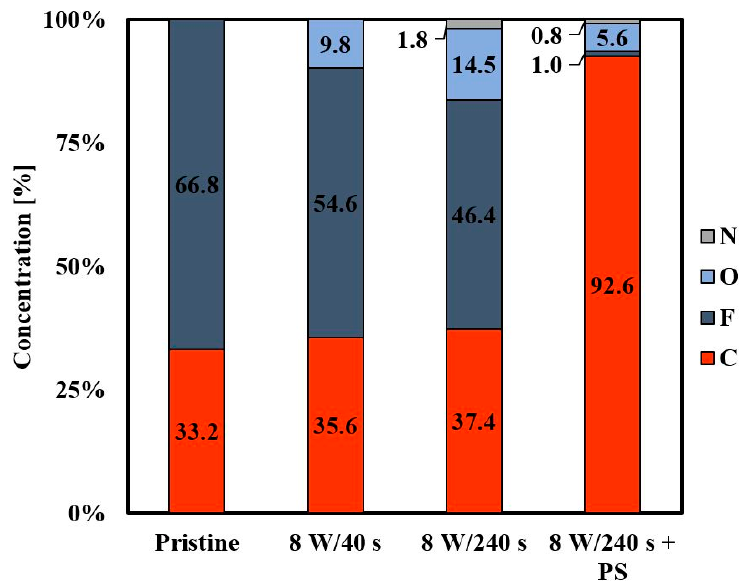
Figure 4. Concentration of elements (C, F, O, N) on pristine fluorinated ethylene propylene (FEP), plasma-treated FEP (8 W/40 s and 8 W/240 s), and subsequently coated with a polystyrene (PS) layer (8 W/240 s + PS).